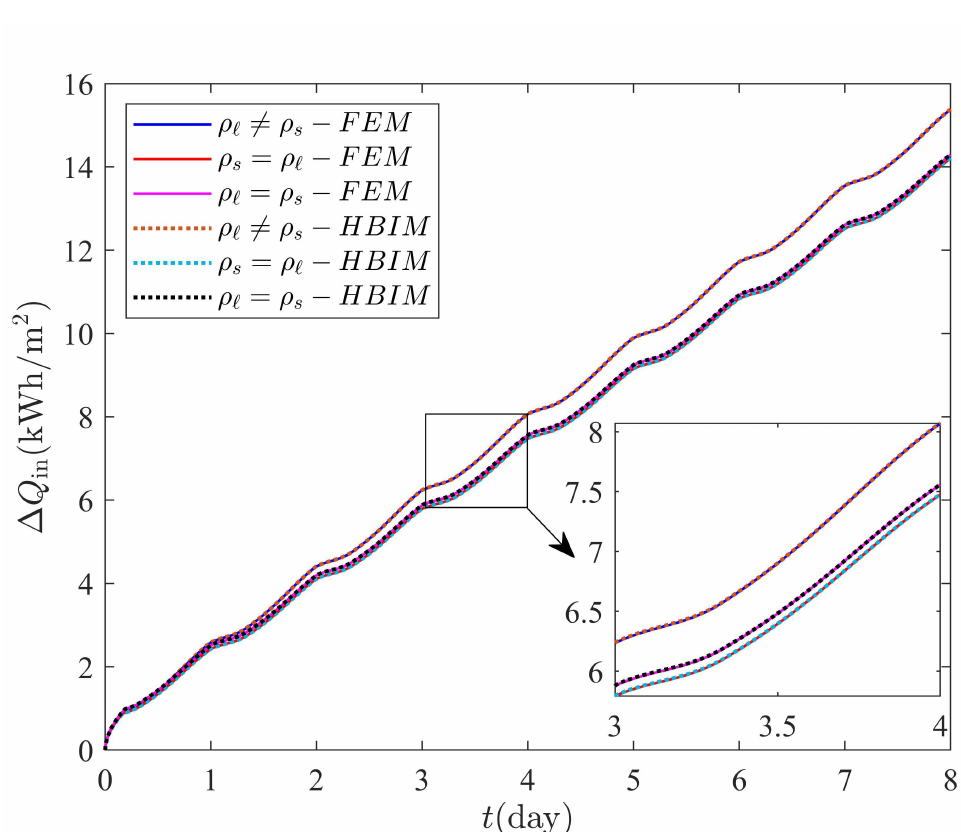
Figure 12. Energy transferred to the interior of the room according to the numerical and semi- analytical solutions used in this work. Constant volume methods of Refs. [21,23–25] are compared with the result obtained through the proposed model in this work. According to the initial state of the system and the result shown in this figure, the thermal performance of the PCM layer is enhanced by assuming equal